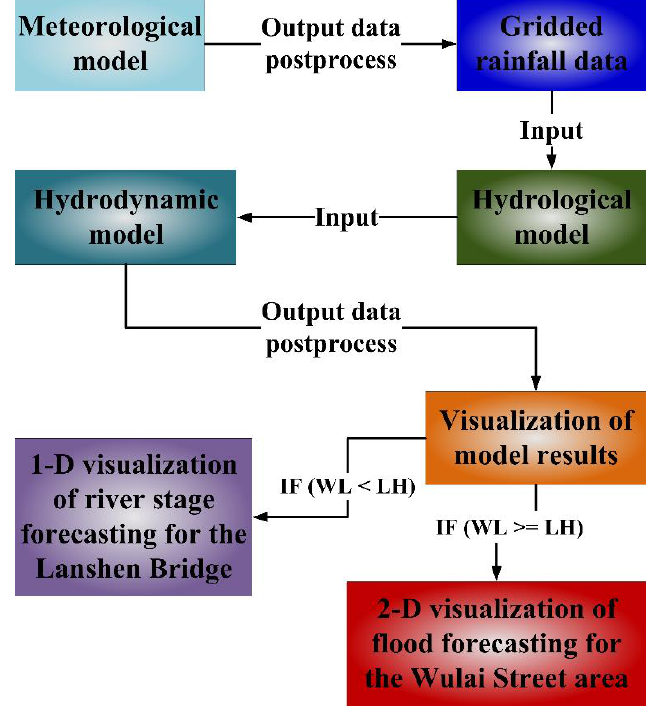
Figure 11. A framework of the operational forecasting system (OFS) for a mountain flash flood (WL and LH represent the water level and the levee height at the Lansheng Bridge, respectively).